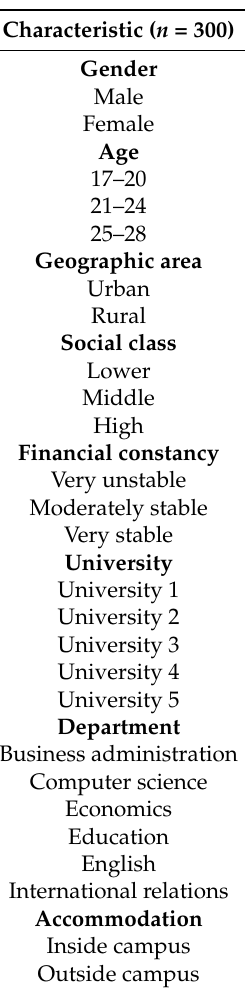
Table 1. Demographic